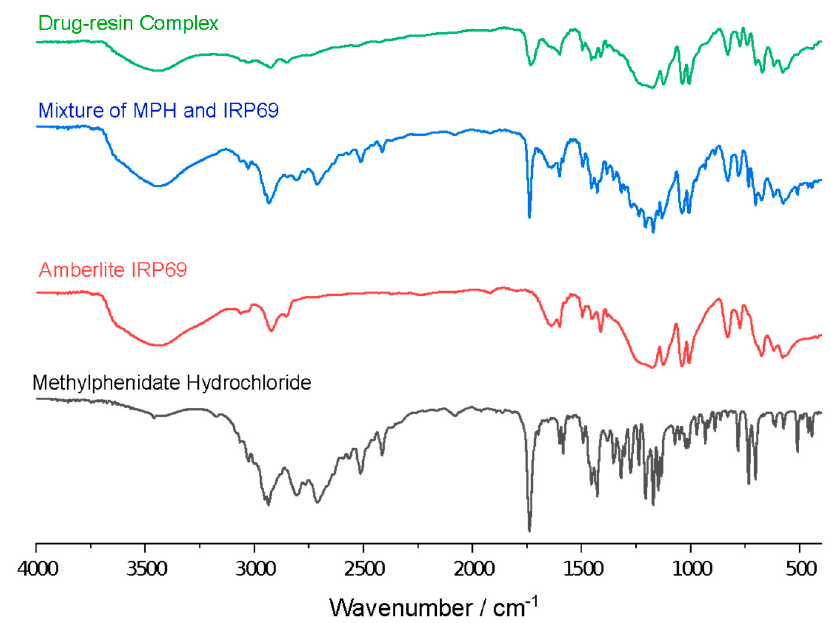
Figure 5. IR patterns of methylphenidate hydrochloride, Amberlite IRP69, a mixture of methylphenidate hydrochloride and Amberlite IRP69, and drug–resin